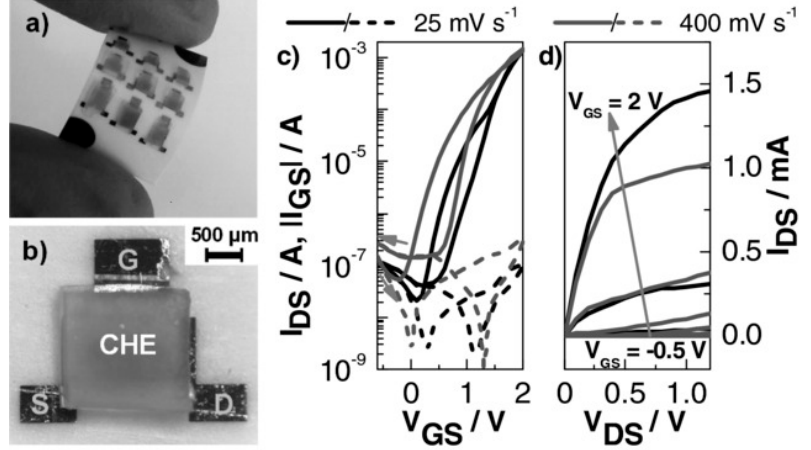
Figure 14. ( a ) Picture of an IGZO-EGT array on paper, with CCHE4 as a solid electrolyte. ( b ) Details of a single EGT. ( c ) Transfer characteristics at two different V GS scan rates. Dashed lines correspond to I GS . ( d ) output curves (gate voltage step of 0.25 V, starting from − 0.5 up to 2 V). Reproduced from [70] with permission. Copyright © 2017 Wiley and Sons.